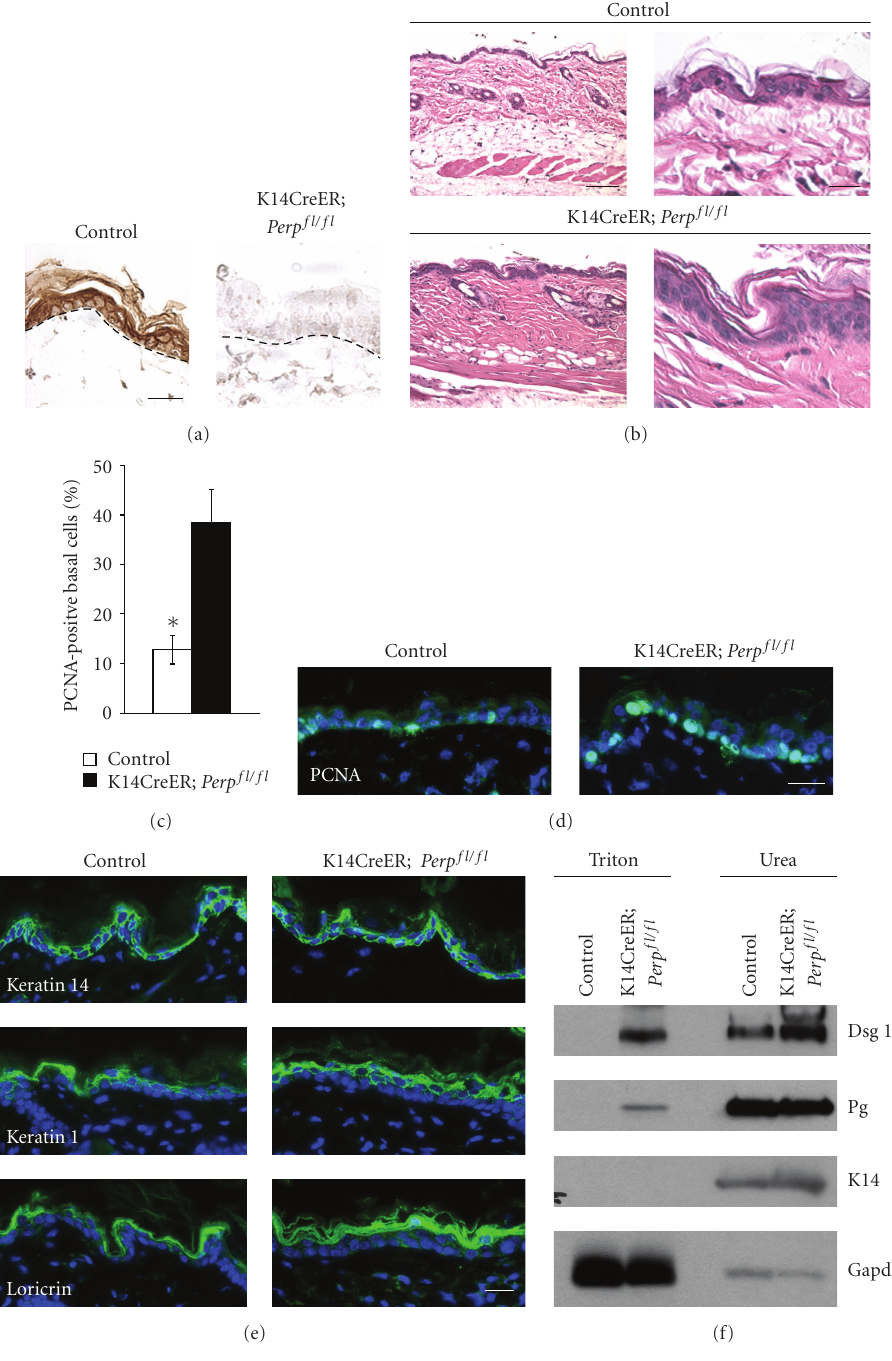
Figure 1: Acute deletion of Perp leads to desmosome defects. (a) Perp immunohistochemistry on skin samples from control ( Perp fl/fl ) and K14CreER; Perp fl/fl mice 4 weeks post tamoxifen injection. (b) H&E analysis of control ( Perp fl/fl ) and K14CreER; Perp fl/fl mice 4 weeks post tamoxifen injection, 200 × and 400 × magnification. (c) Graph displays the average percentage of PCNA positive cells in the basal cell layer in both control ( Perp fl/fl ) and K14CreER; Perp fl/fl mice 4 weeks post tamoxifen injection. Graph represents the average of 3 separate fields from each of 4 mice +/ − SEM. Statistical significance was determined using the Mann-Whitney test ∗ = P < . 03. (d) Representative image of the proliferation in the basal layer of the epidermis measured by PCNA immunostaining in control ( Perp fl/fl ) and K14CreER; Perp fl/fl mice 4 weeks post tamoxifen injection. (e) Immunofluorescence analysis of di ff erentiation markers on control ( Perp fl/fl ) and K14CreER; Perp fl/fl mice 4 weeks post tamoxifen injection. Keratin 14, Keratin 1, and Loricrin mark the basal, the spinous, and the granular layers, respectively. DAPI is used to mark nuclei. (f) Solubility/western blot analysis of Dsg1 and Pg in K14CreER; Perp fl/fl or control ( K14CreER; Perp + / + ) mouse skin. Both Triton X-100-soluble and Urea fractions are presented. Gapdh and Keratin 14 serve as loading controls for the Triton X-100 and urea fractions, respectively. Scale bar for panels (a, b) (right column), (d), and (e) equals 20 μ m. Scale bar for panel (b) (left column) equals 100 μ